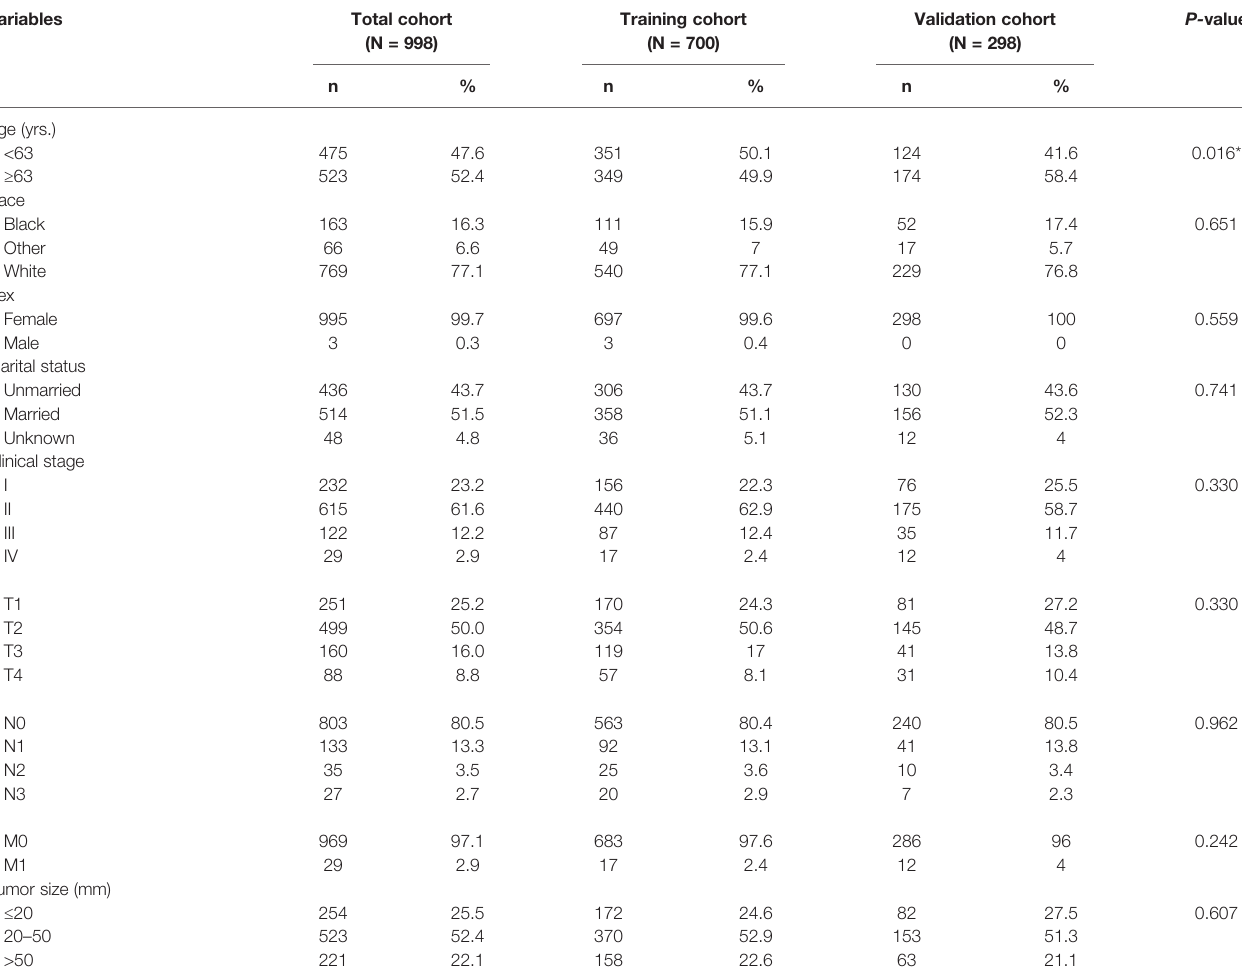
TABLE 1 | Characteristics of TN MpBC patients after surgery.